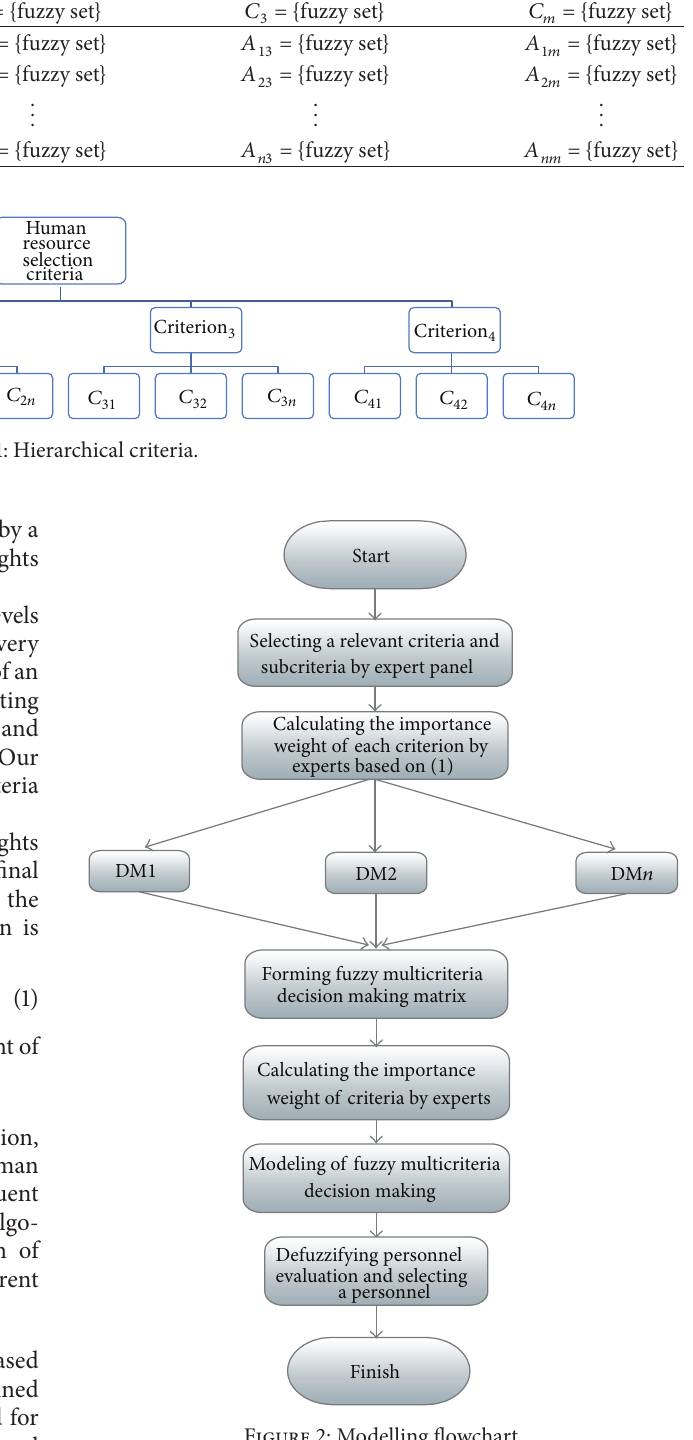
Figure 2: Modelling